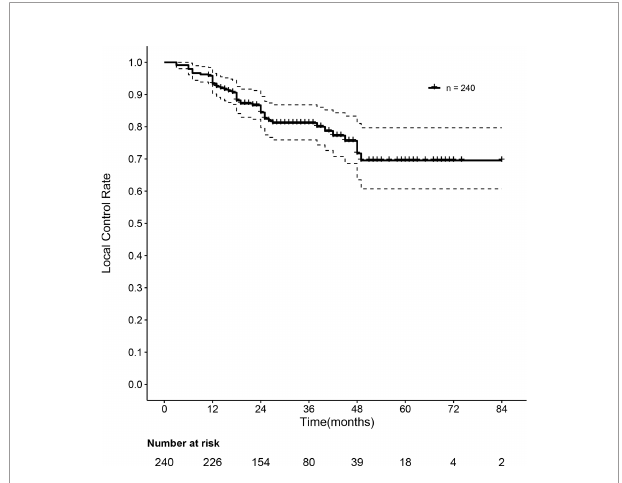
FIGURE 2 | Curve of the local control rate of 240 HBV-related sHCC patients after SBRT. HBV, hepatitis B virus; sHCC, small hepatocellular carcinoma; SBRT, stereotactic body radiation therapy.